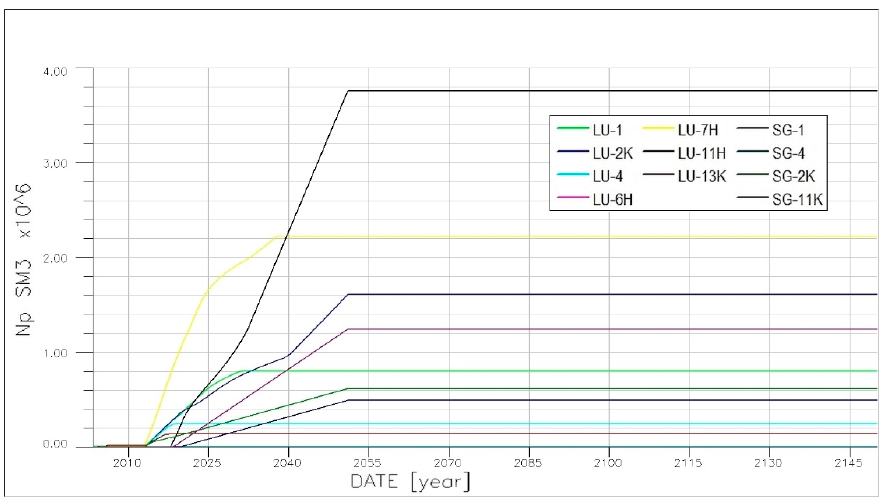
Figure 15. Basic scenario of oil production by enhanced oil recovery (EOR) with CO 2 injection. Np is the total oil production of individual wells.